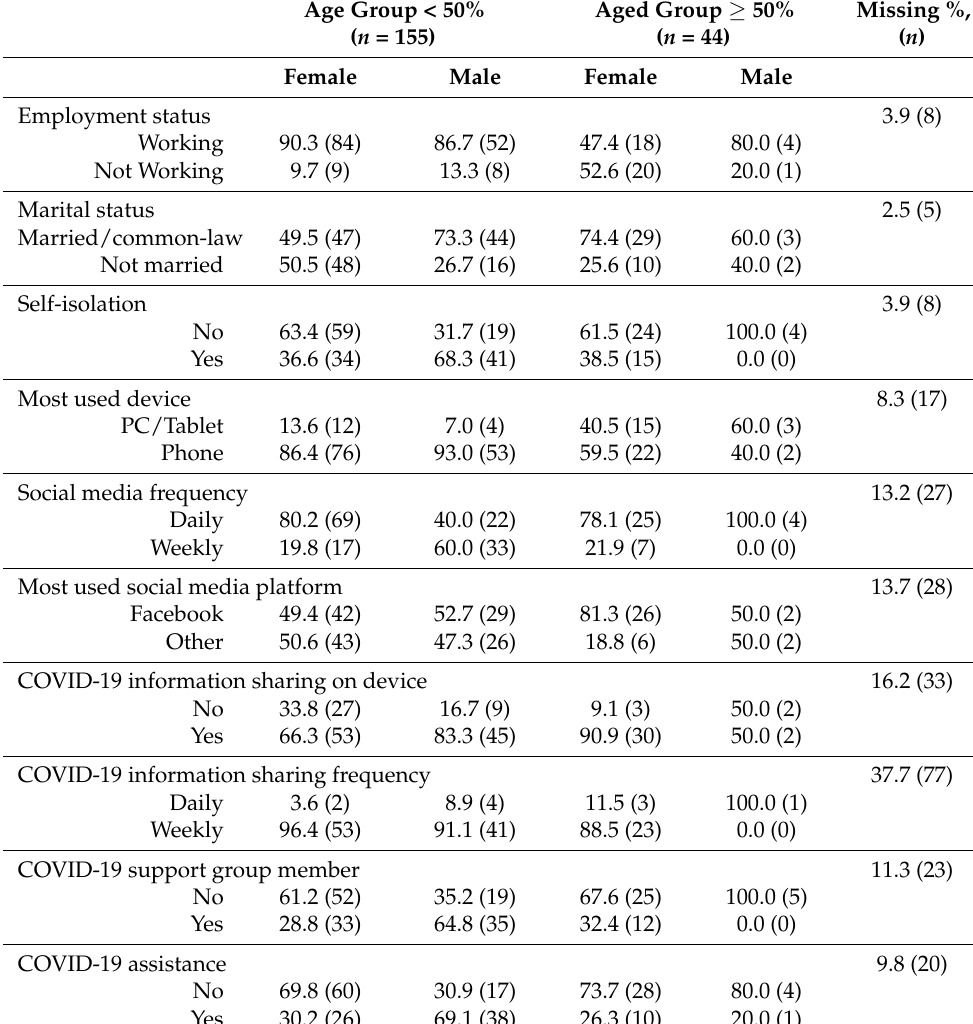
Table 6. Key variables stratified by age and gender ( n =